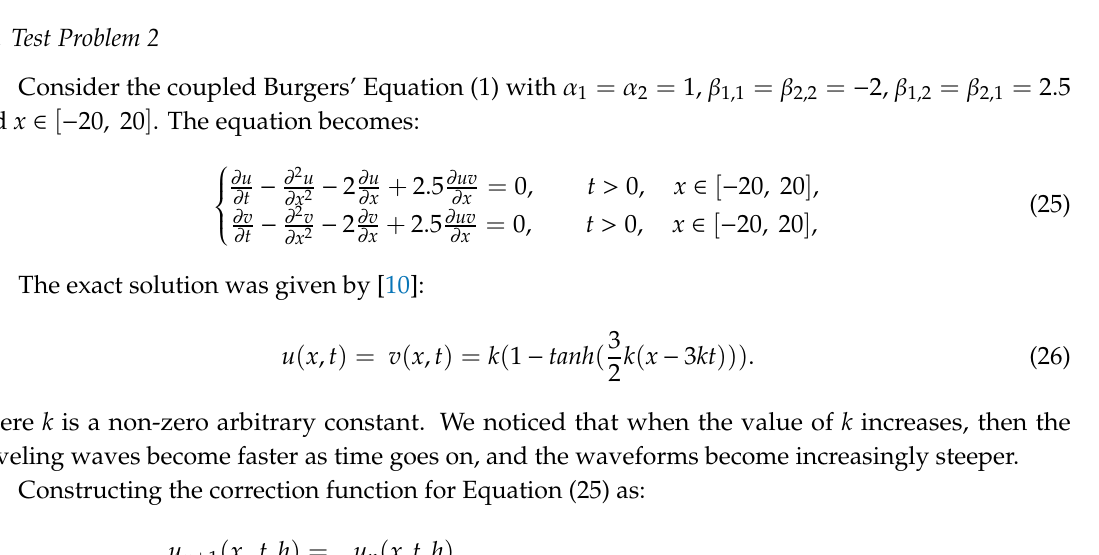
Figure 4. Approximation solution of u ( Left ) and approximation solution of v ( Right ) for different values of t .